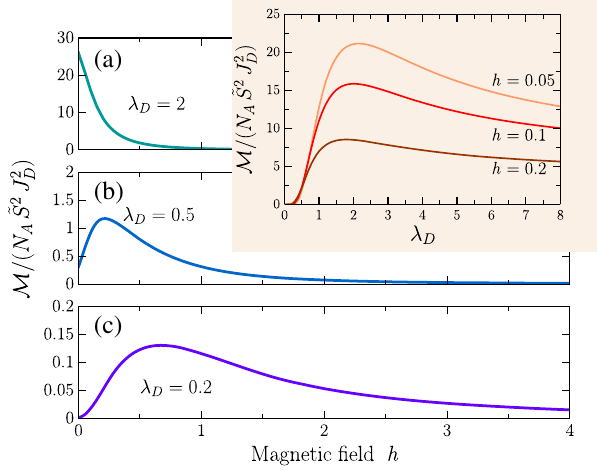
FIG. 5. Magnetic field dependence of the mass term M in the presence of a defect for a Skyrmion with κ ¼ 0 . 7 , J x ¼ T ¼ 0 . We depict three different values of defect size λ 0.5 (b), and 0.2 (c). The inset shows the dependence of M on the defect size λ for a Skyrmion with h ¼ 0 . 2 , 0.1, 0.05 and D Skyrmion radius λ ¼ 1 . 26 , 1.57, 1.79,